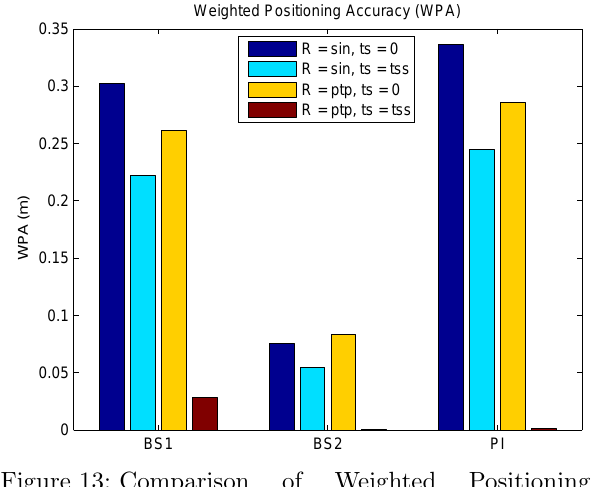
Figure 13: Comparison of Weighted Positioning